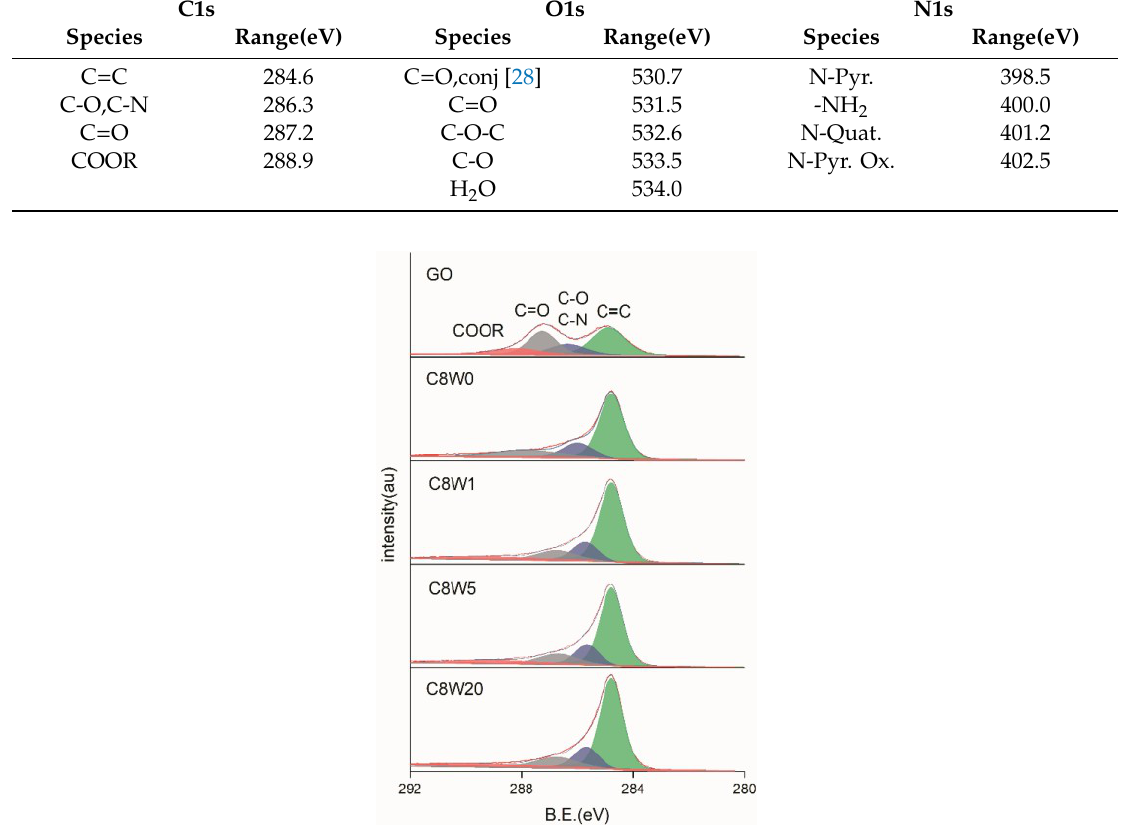
Figure 5. C1s X-ray electron spectroscopy (XPS) fitting curves for different microwave processing durations.